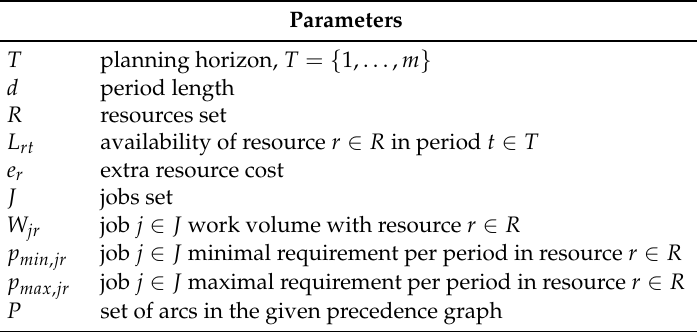
Table 1. Model nomenclature: Parameters